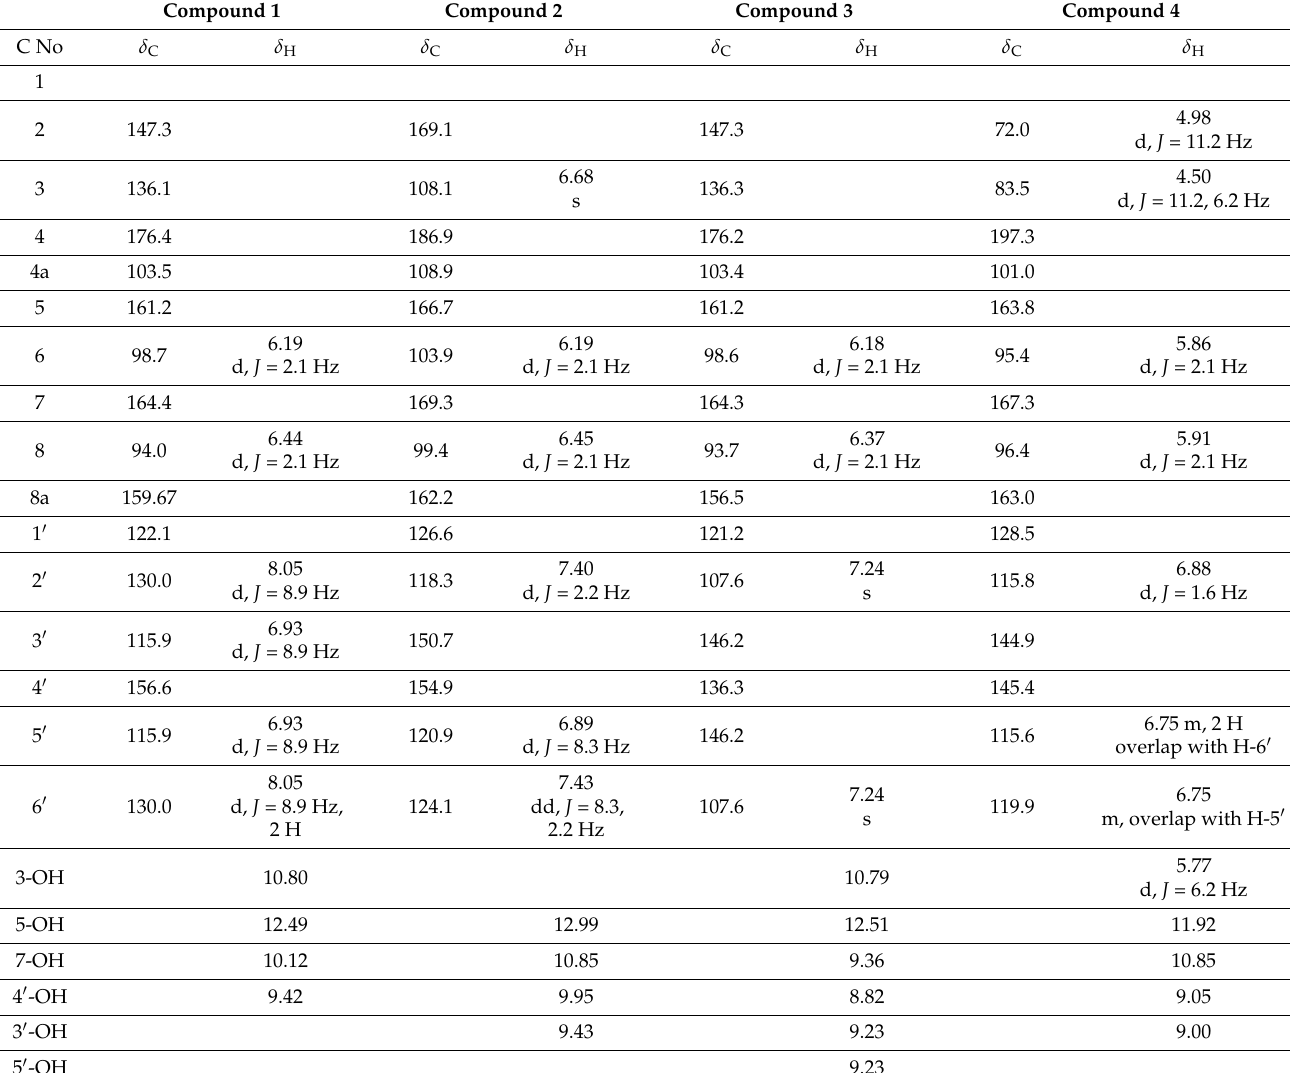
Table 1. 1 H and 13 C spectral data of 1 – 4 (DMSO-d 6 , 400 Hz, δ in ppm, J in